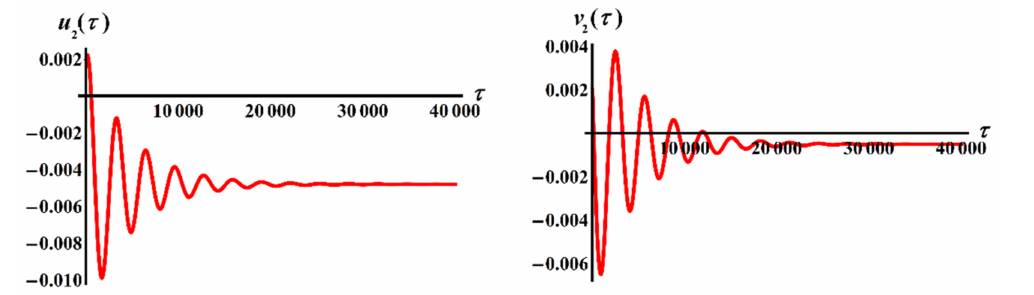
Figure 27. The time histories of u 1 and v 1 .